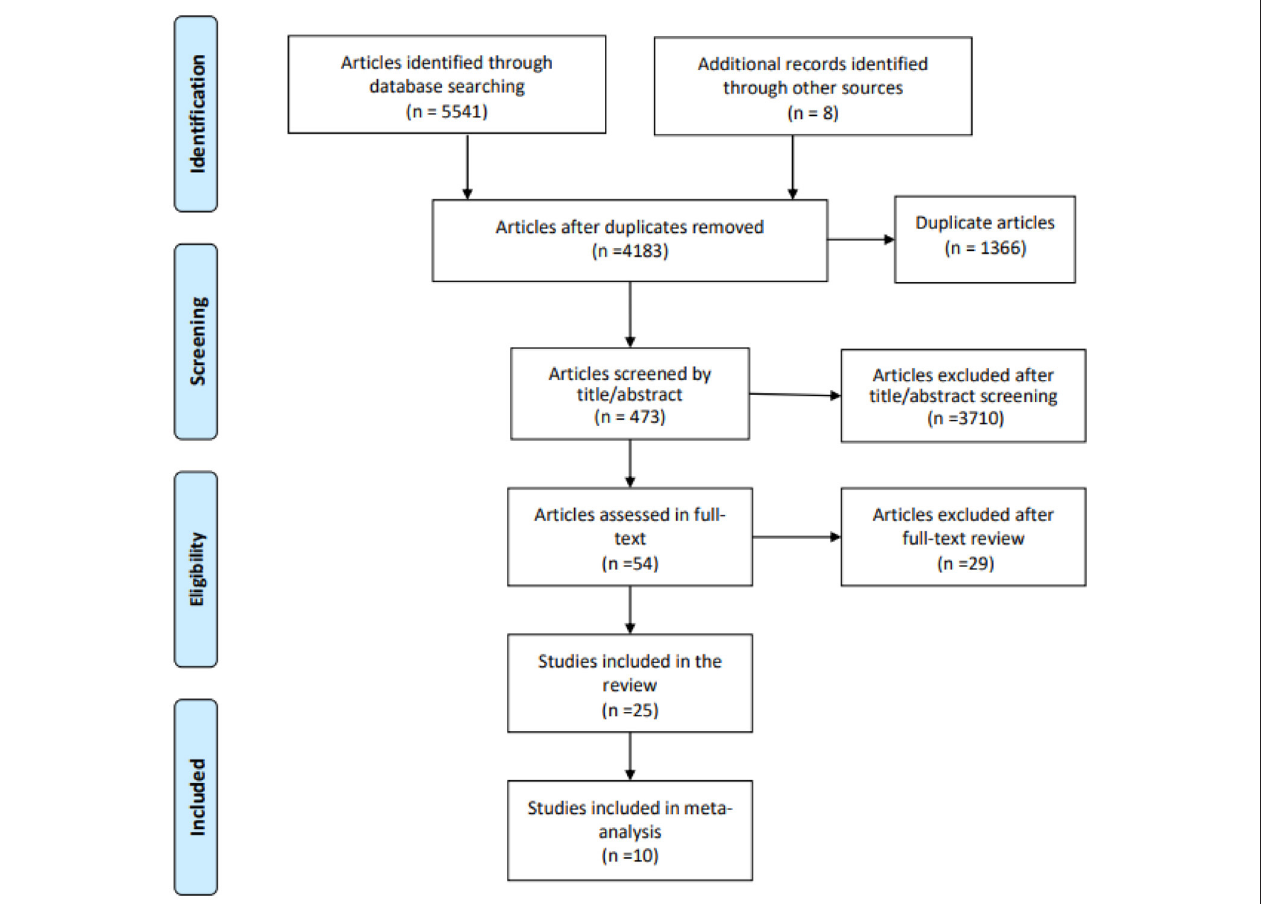
FIGURE 1 | Flowchart of the selected literature.